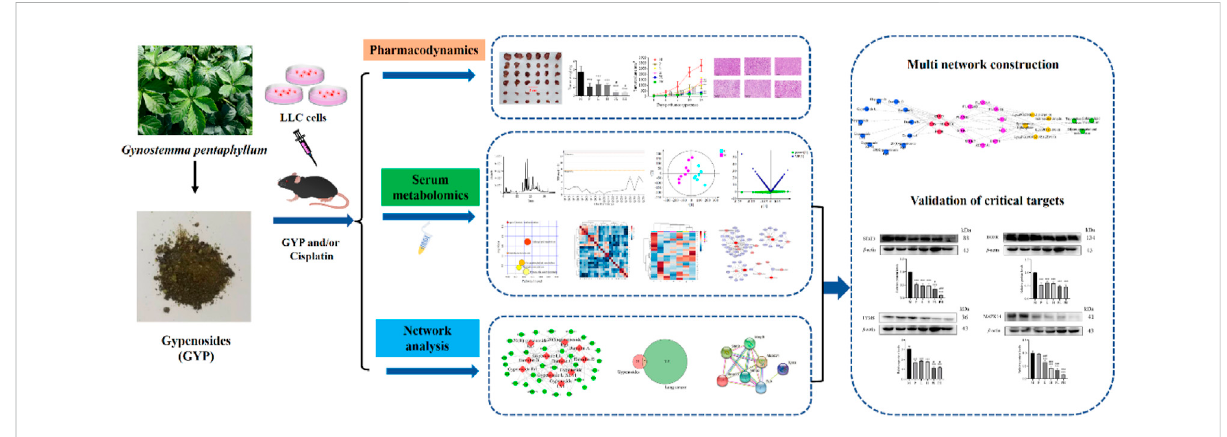
FIGURE 1 The fl ow chart of this